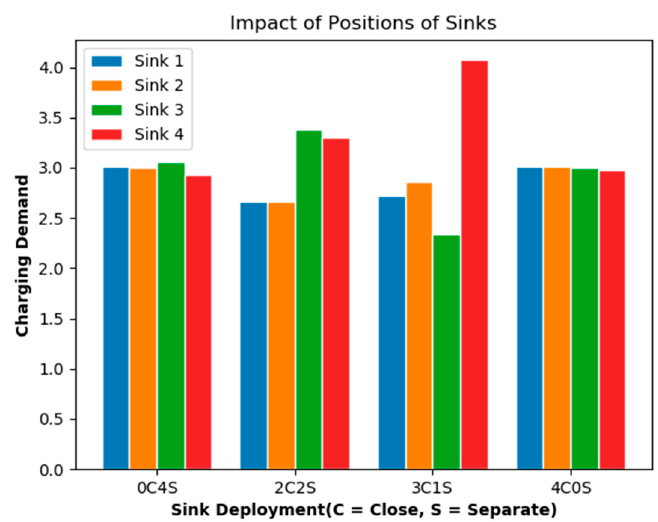
Figure 14. The impact of different densities on the energy requirements of sink nodes.